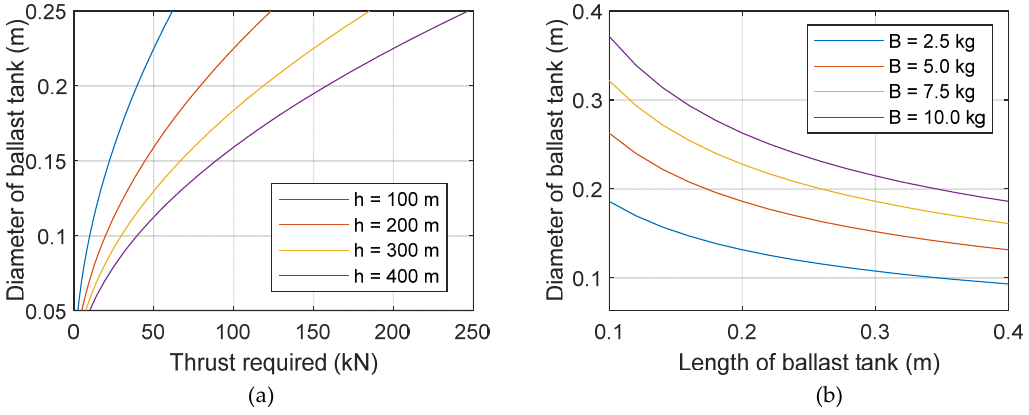
Figure 4. ( a ) Computed length vs. diameter of piston operated cylindrical ballast tank, ( b ) Thrust required at piston head vs. diameter of piston operated cylindrical ballast tank.